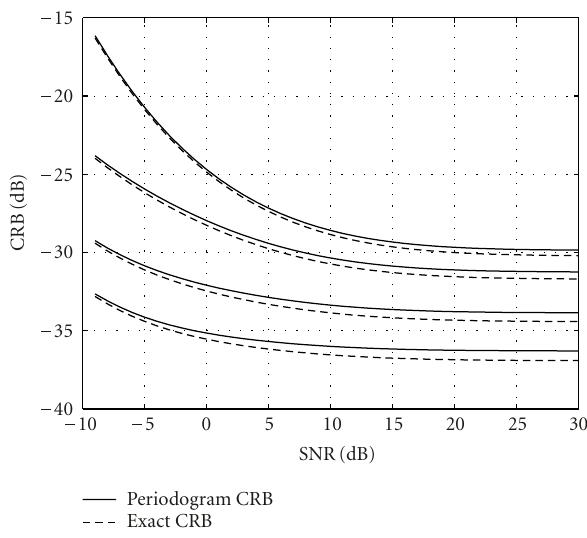
Figure 4: The floor e ff ect of the periodogram-based asymptotic CRB and the exact CRB for di ff erent values of κ . κ = 0,0 . 1,0 . 2,0 . 3 from top to bottom, N = 128, f d = 0 . 3.